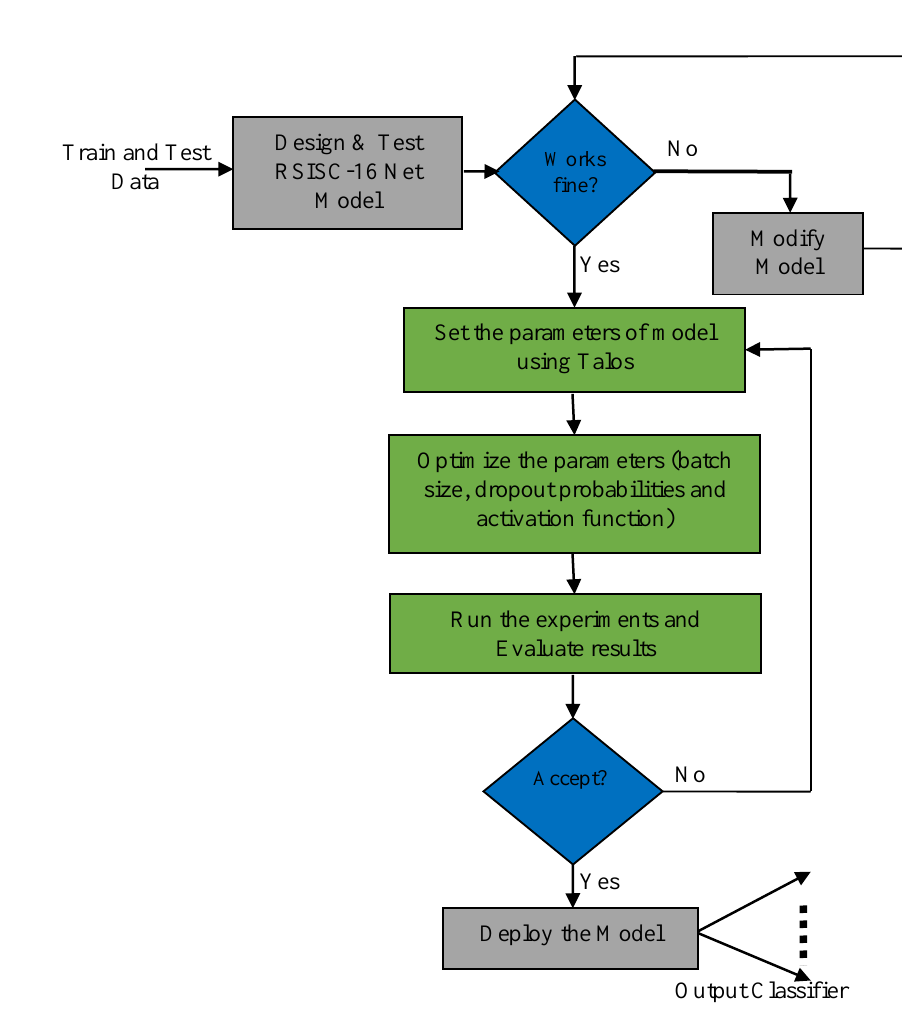
Figure 3. Flowchart of RSISC-16 Net Model Optimization